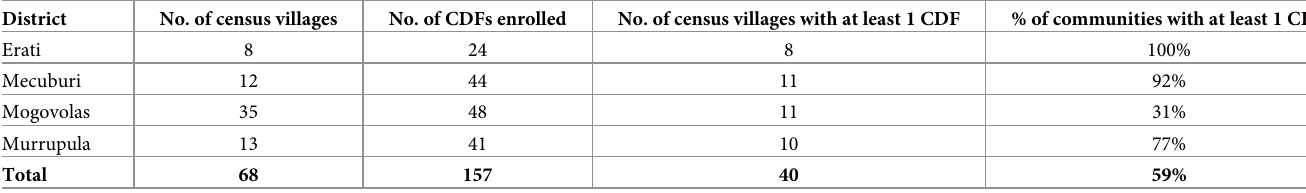
had at least one CDF enrolled at the end of the sensitisation and selection exercise as shown in Table 5. The gap in communities covered is mainly attributable to an issue associated with the district of Mogovolas, and more precisely to the Nametil locality, where a large number of cen- sus villages were not covered. It was not possible to reconcile the list of census villages with the list of communities used at health centre level, due to varied local understandings of the term Table 5. Communities targeted vs. reached by the intervention. District No. of census